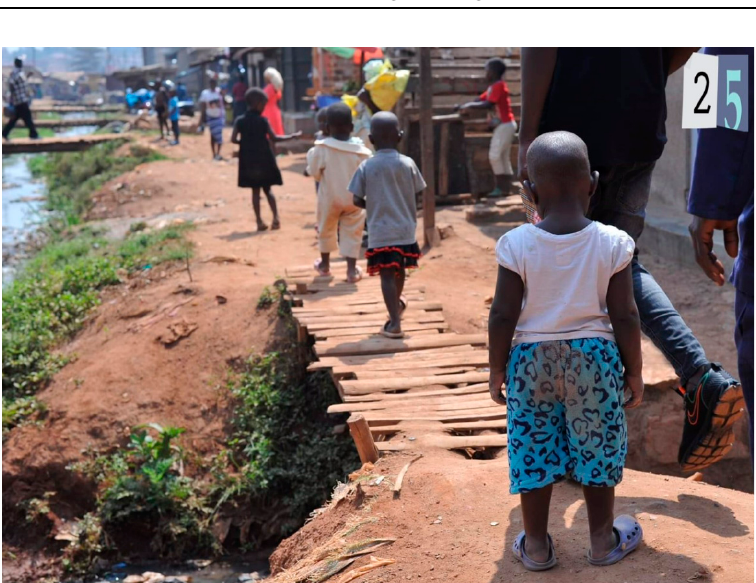
Figure 2. Community Latrine (photo number 20).